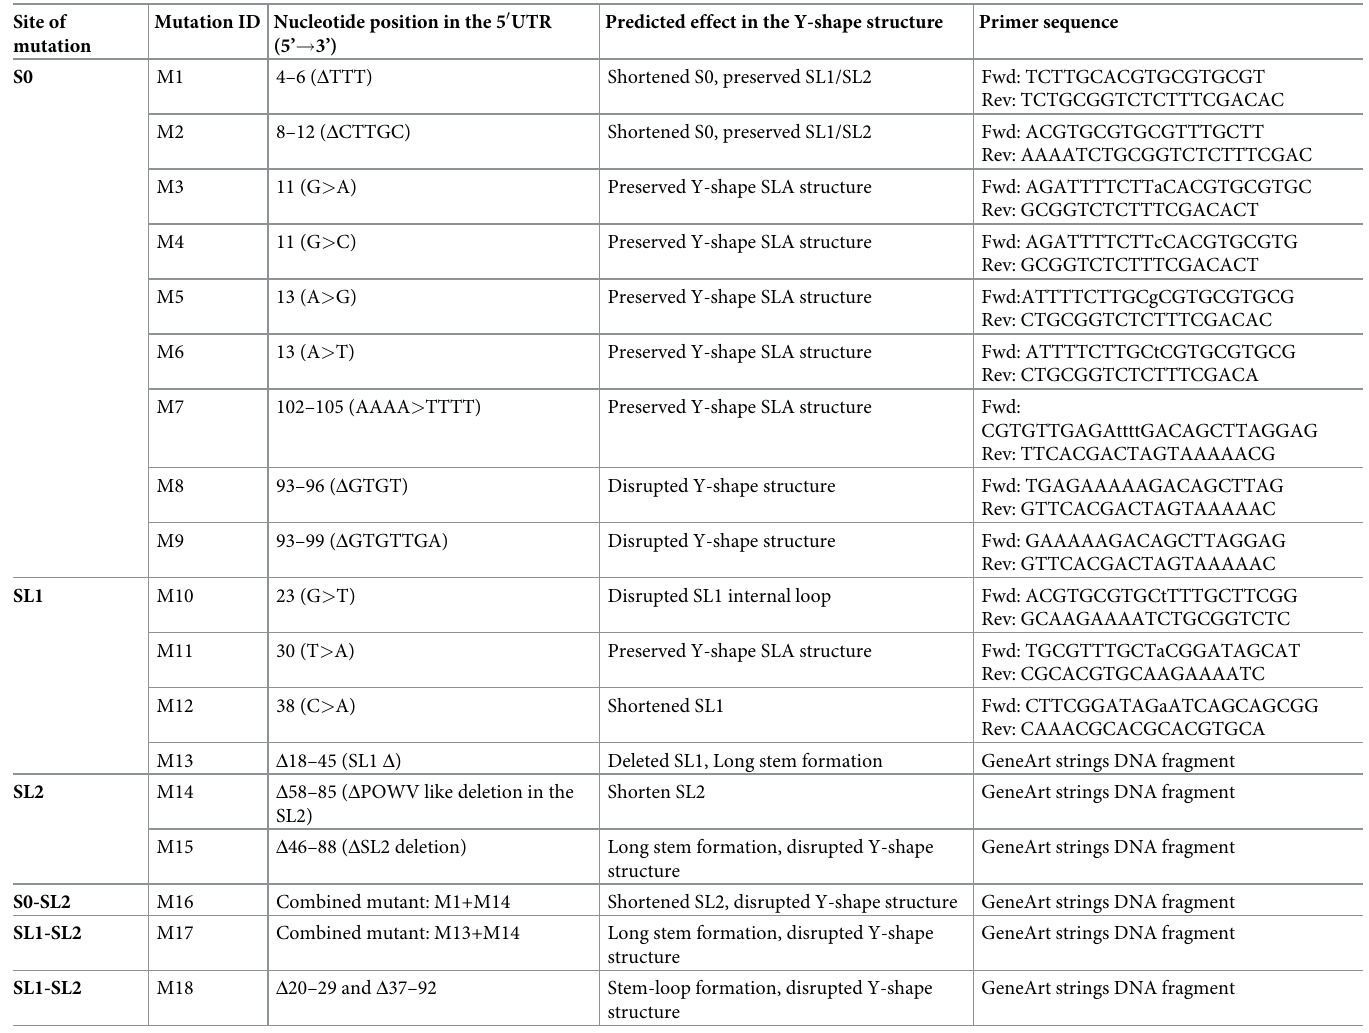
Table 1. Mutants and primers used in the study. Site of